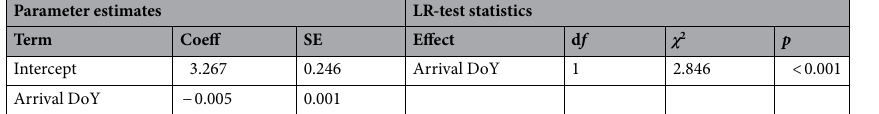
Table 3. Logit-parameter estimates and corresponding likelihood-ratio test statistics for the most supported model fitted to predict progression time through the minimum flow stretch for Atlantic salmon spawners arriving to the lowermost PIT-antenna in River Nidelva at different dates